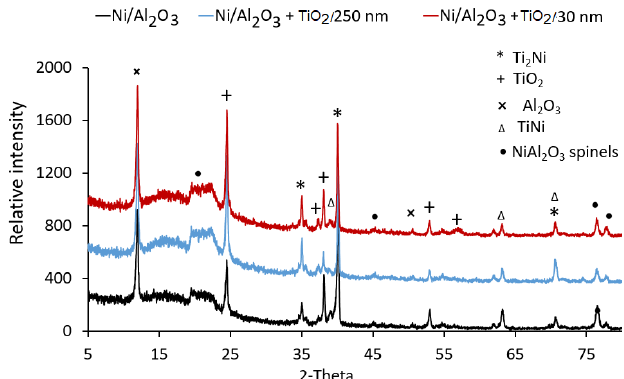
Figure 9. XRD analysis of Ti-6Al-4V samples electroplated with three di ff erent coatings and surface melted with GTAW.